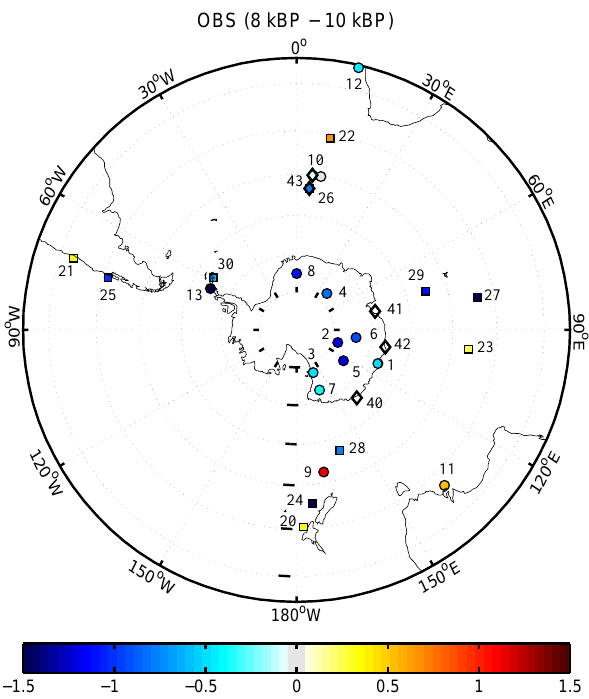
Fig. 1. Available early Holocene temperature data at high southern latitudes. Colors show the temperature differences between 8 and 10ka. Circles correspond to the proxy data used in the simulations with data assimilation. Squares depict available proxy data that are not used in the simulations with data assimilation, because of either low resolution or not covering the reference or fossil periods (cf. Sect. 2.3 for more explanation). Both types of data are taken into account to validate the simulations. Diamonds refer to qualitative data that are not used to compute MAE in Table 3. A description of these proxies is shown in Tables 1a, b and